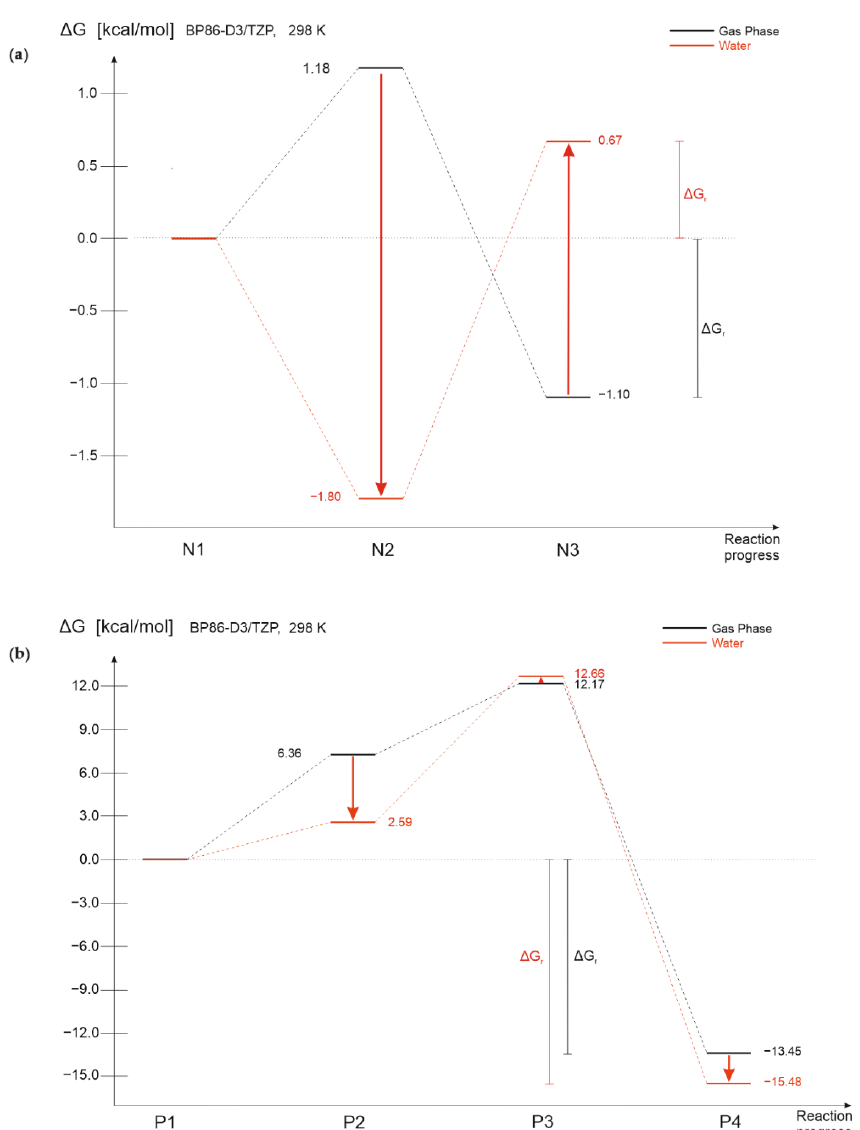
Figure 8. Relative Gibbs free energies of ( a ) nylon 6 and ( b ) PHB structures obtained for gas phase (black lines) and water presence (red lines) in 298 K.